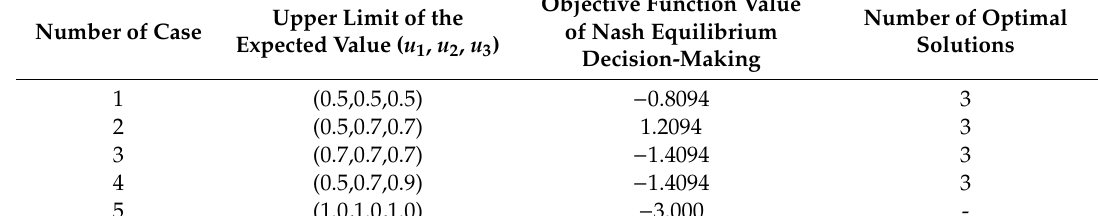
Table 3. Solutions of the mixed strategy Nash equilibrium decision-making method with di ff erent u i .